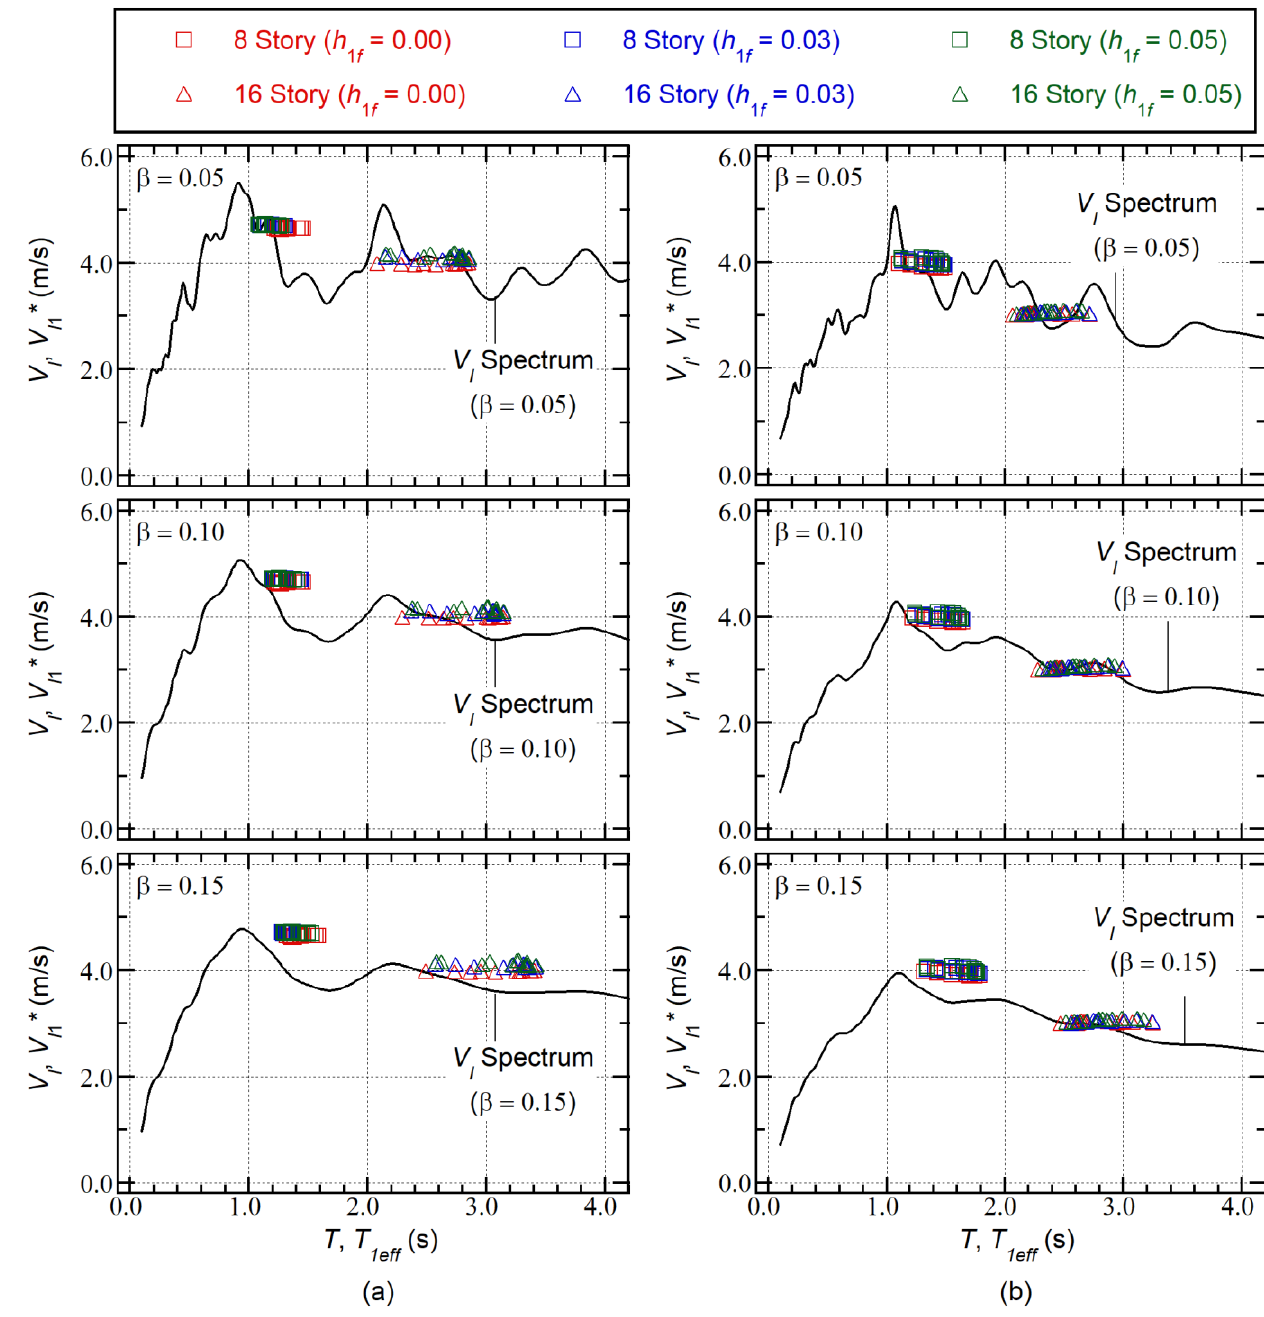
Figure 19. Comparisons of the V I spectrum and V I 1 ∗ obtained from the time-history analysis: ( a ) Art-L series; ( b ) Art-S series.